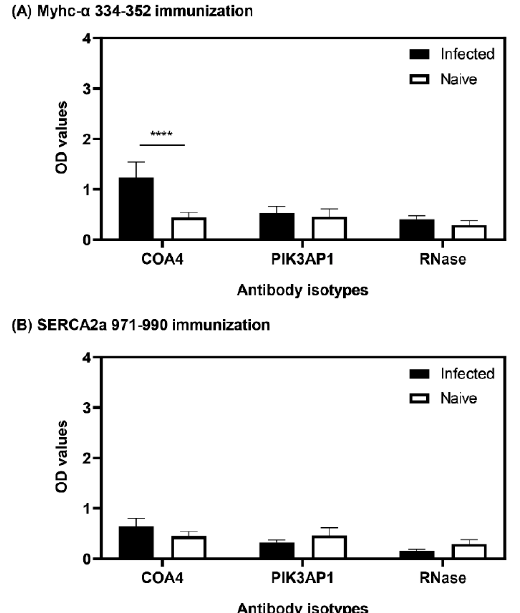
Figure 8 . Animals immunized with Myhc- α 334-352 reveal the presence of autoantibodies to COA4. Figure 8. Animals immunized with Myhc- α 334–352 reveal the presence of autoantibodies to COA4. ( A , B ) Myhc- α 334–352 and SERCA2a 971–990 immunization. A/J mice were immunized with Myhc- α 334–352 or SERCA2a 971–990 in CFA emulsions or saline, and sera were collected 21